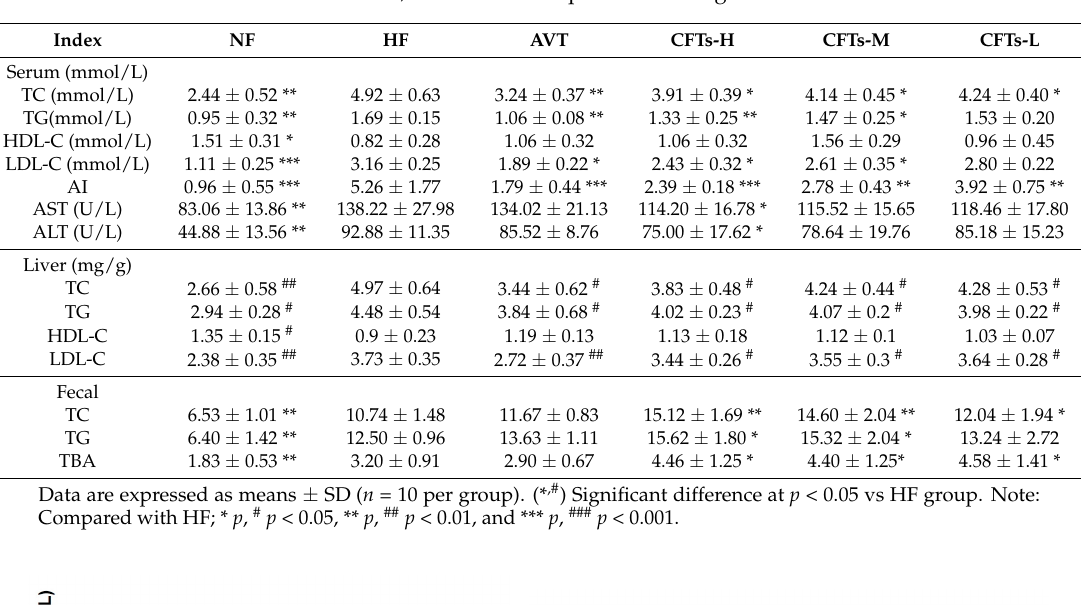
Table 1. The serum, liver and fetal lipid levels in high-fat diet rats.